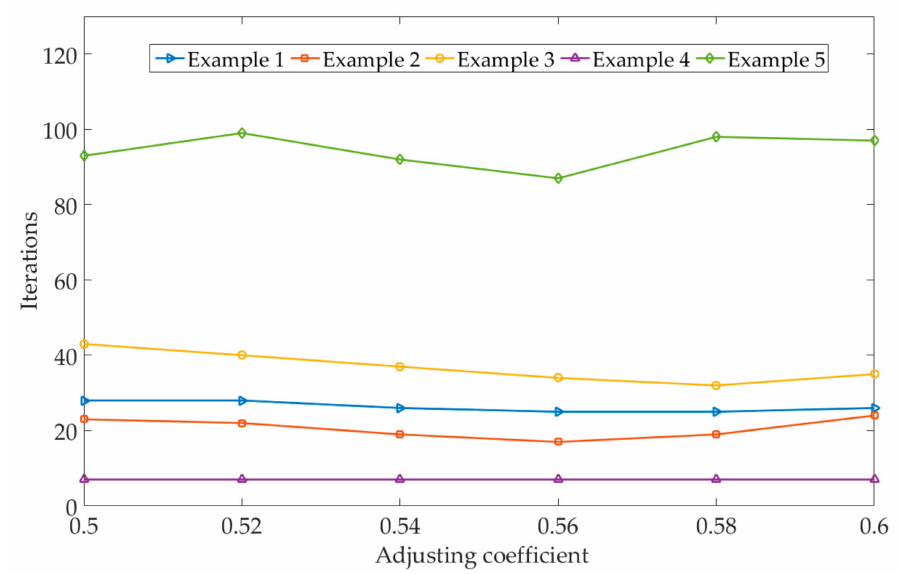
Figure 12. Iterations of the proposed AFSL algorithm with di ff erent adjusting coe ffi